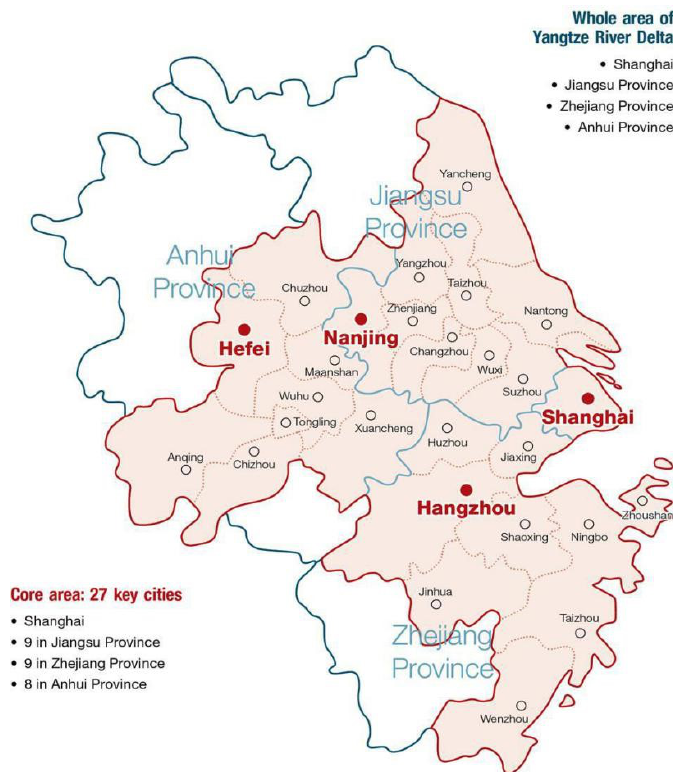
Figure 1. Planning scope for the YRD region (source from Shanghai Daily website).